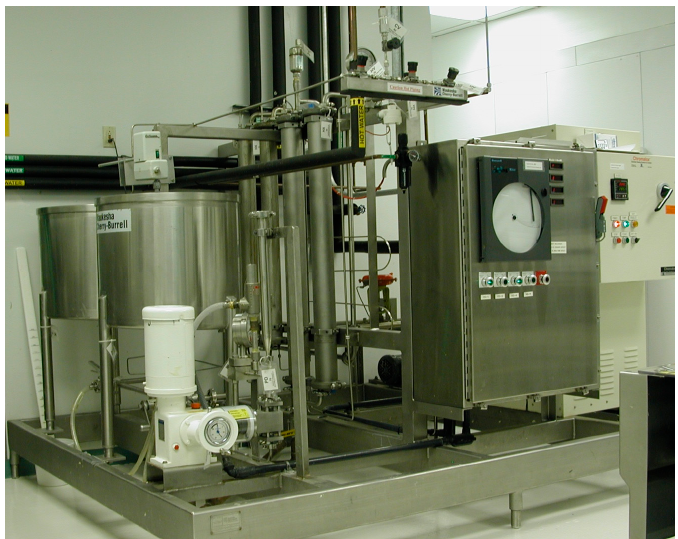
Figure 1. Frontier Scientific’s flash sterilization system used for the processing of insect media. From left to right: diet tank, pump, processing tubes, coiled spiraltherms, and control station.